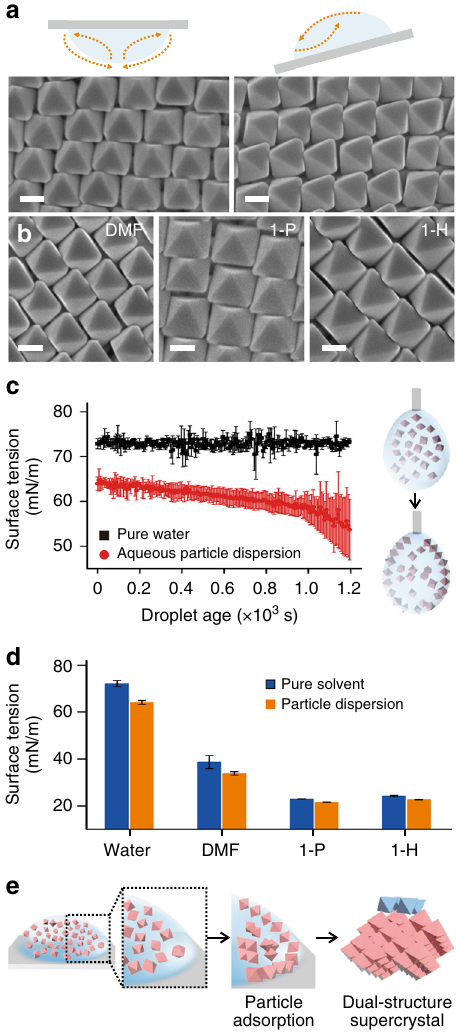
Fig. 4 Air/liquid interface drives open structure formation. a Open structure persists when the droplet dries in an upside-down con fi guration or at a tilt angle. Schematics illustrate assembly setups, arrows indicate direction of solvent fl ow. b Open structure formation in N , N -dimethylformamide (DMF), 1-propanol (1-P), and 1-hexanol (1-H). All scale bars, 200 nm. c Time-dependent surface tension measurements of an aqueous particle- loaded pendant drop (red line) and a pure solvent pendant drop (black line). d Solvent-dependent surface tension measurements in water, DMF, 1- P, 1-H. e Schematic illustration of Ag octahedra adsorbing to the air/liquid interface; subsequent solvent evaporation lead to dual-structure supercrystals. Error bars in c and d are s.d. of at least 10